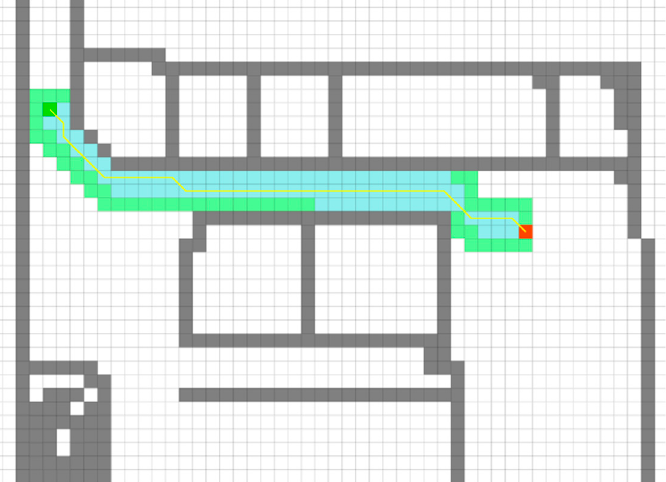
Figure 12. A* algorithm for path finding. A cross section of the floor is used to generate the 2D occupancy grid. The dark green cell is the start location and the red cell is the goal location. The gray cells are occupied, and the white cells are free. A path is computed by applying the A* algorithm and waypoints are generated using the centroids of the grid cells.